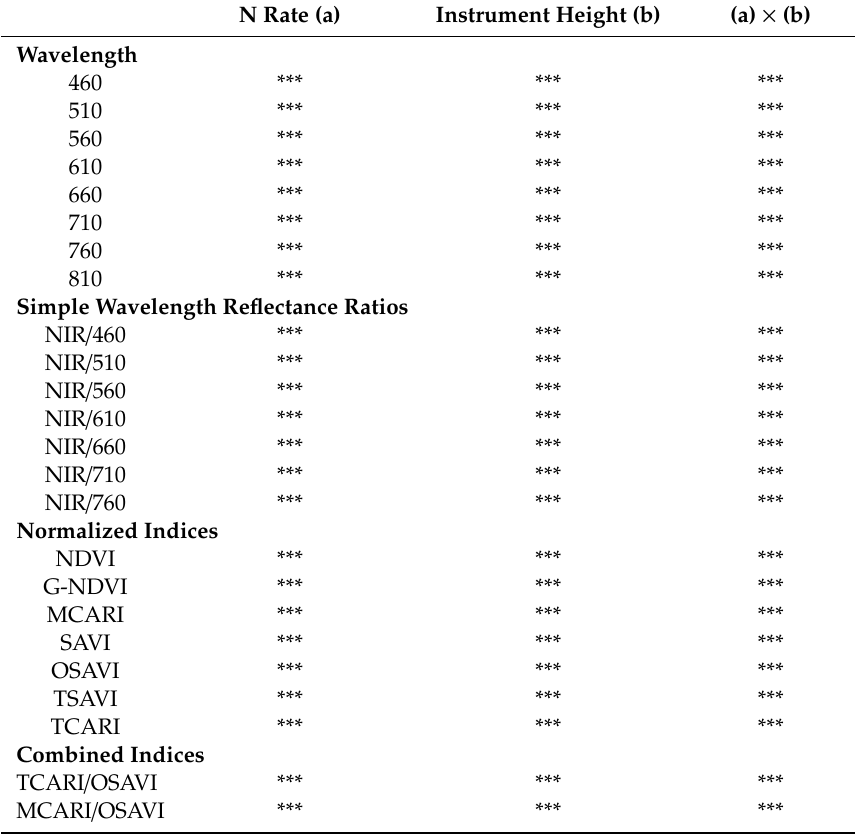
Table 2. Experiment 1#. Statistical significance of each of the factors (N rate, and instrument height) and of the interaction between factors by ANOVA. * p < 0.05, ** p < 0.01, *** p < 0.001, NS not